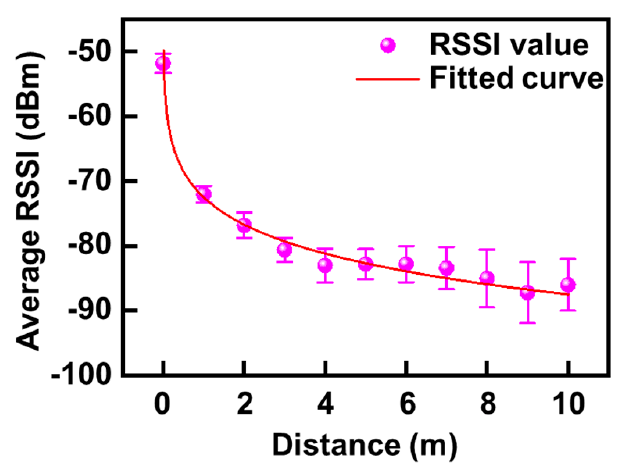
Figure 2. Curve fitting for received signal strength indicator (RSSI) values at distances of 0–10 m in an open environment.